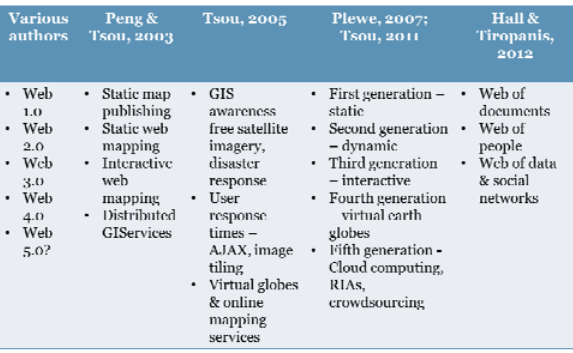
Table 1: Various characterisations of web mapping developments in the